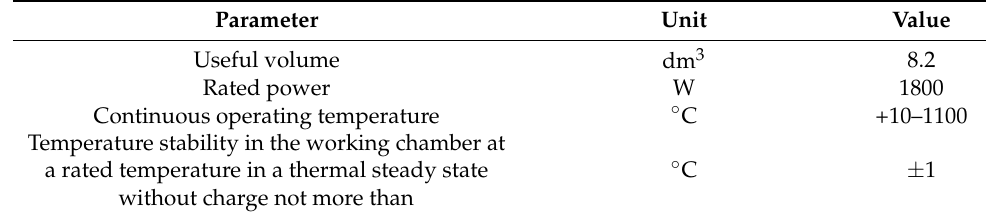
Table 4. Technical specifications of the SNOL 8.2/1100 muffle furnace.